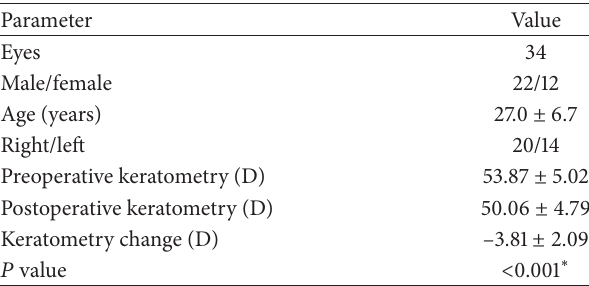
Table 1: Patient demographics.